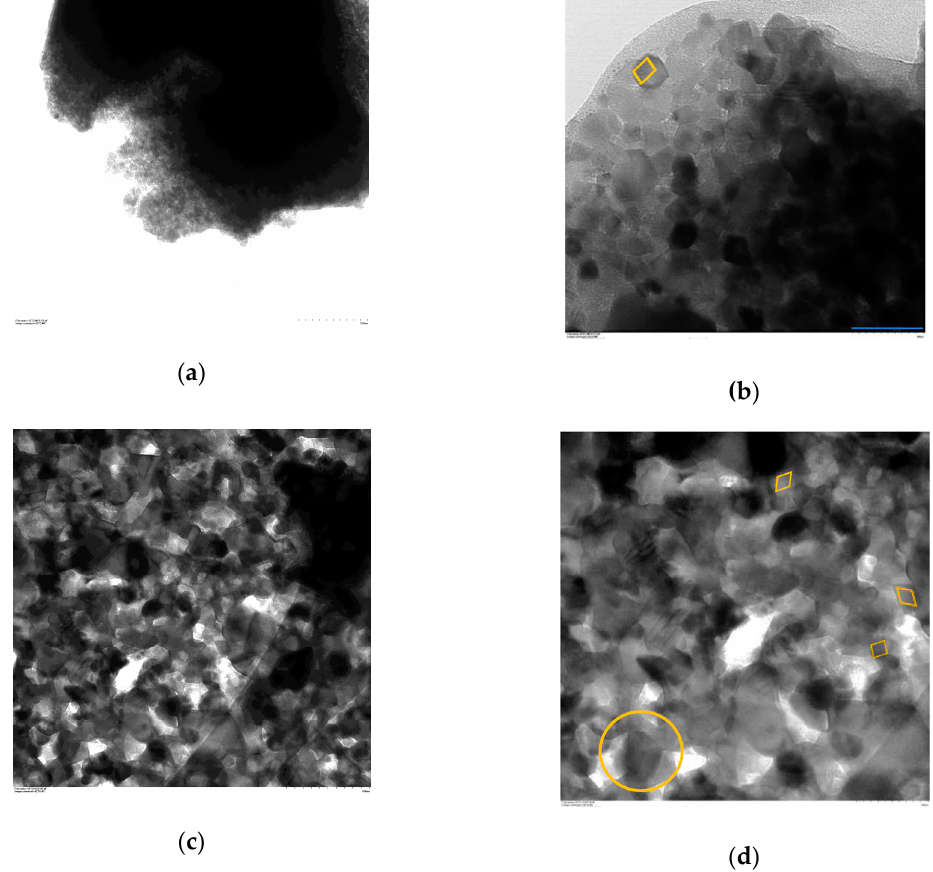
Figure 3. TEM images of cds-ZTO ( a , b ) and p-ZTO ( c , d ).